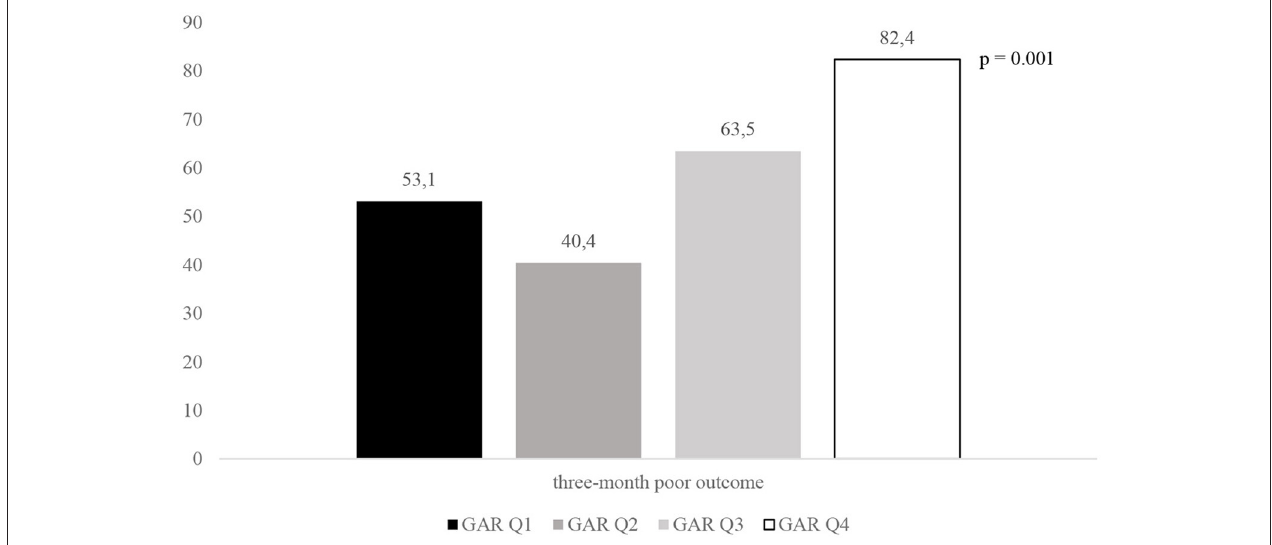
FIGURE 2 | Rates of 3-month poor outcome according to GAR quartile. GAR Q1, first glucose-to-glycated hemoglobin ratio quartile; GAR Q2, second glucose-to-glycated hemoglobin ratio quartile; GAR Q3, third glucose-to-glycated hemoglobin ratio quartile; GAR Q4, fourth glucose-to-glycated hemoglobin ratio quartile.